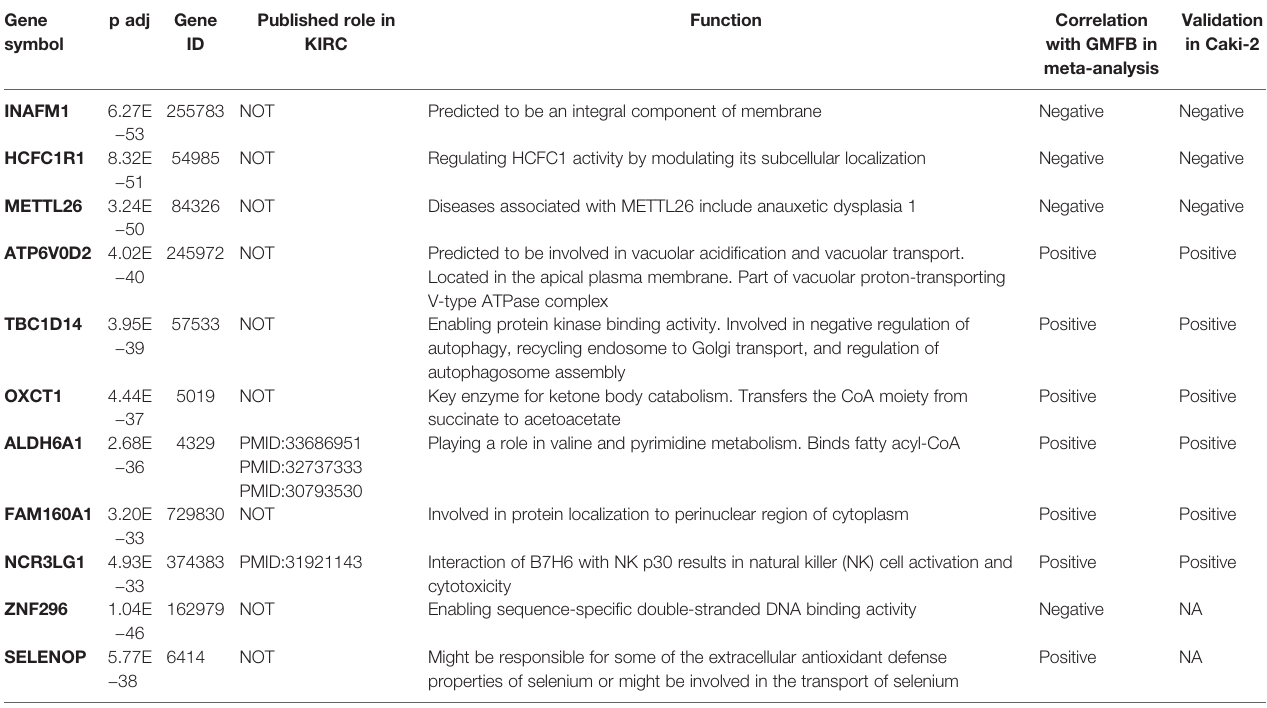
TABLE 4 | The signi fi cant DEGs with